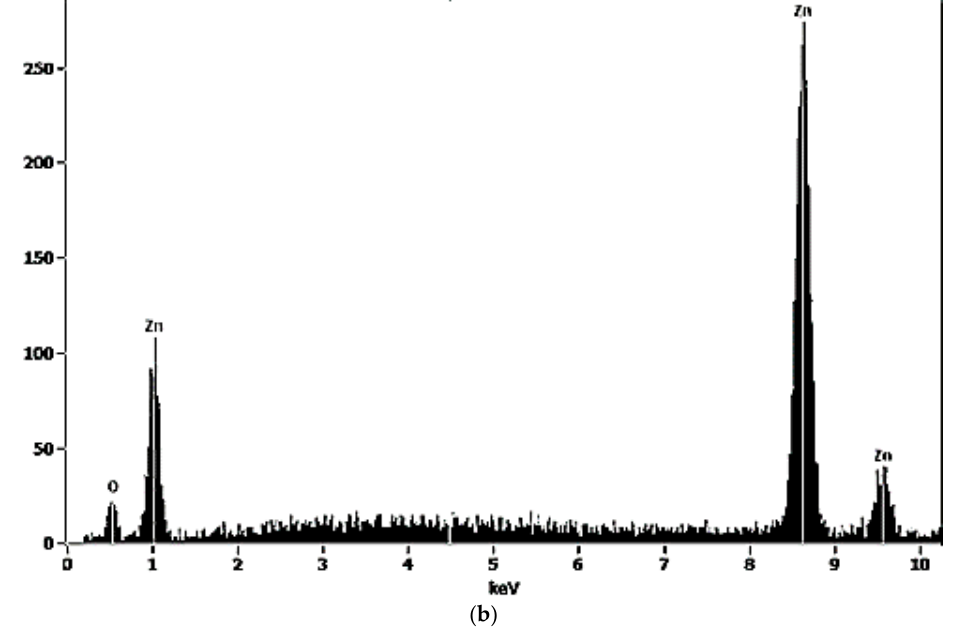
Figure 4. Structure of nZNO obtained in run 23 ( a ), and 8 ( b ) (EHT = 20.00 kV, Mag = 160.00kx, WD = 9.5 mm).